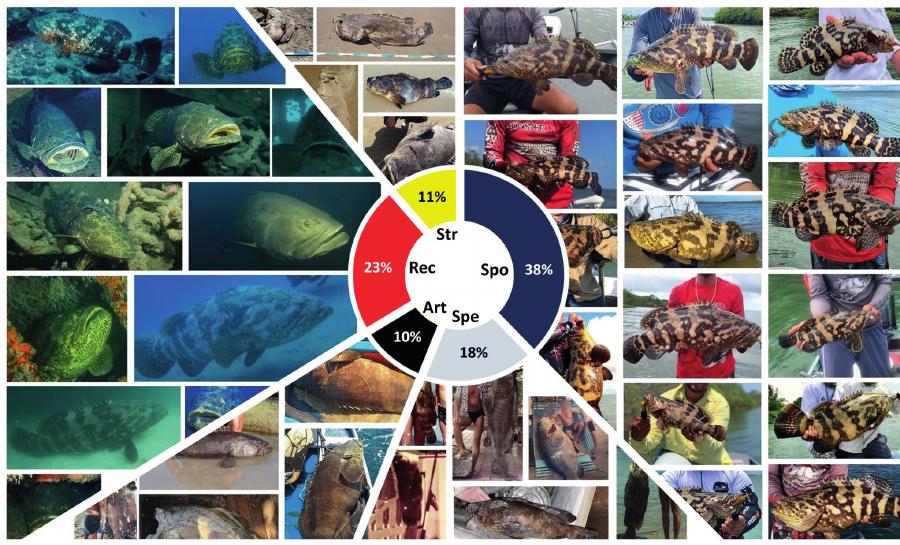
FIGURE 2 | Percentage